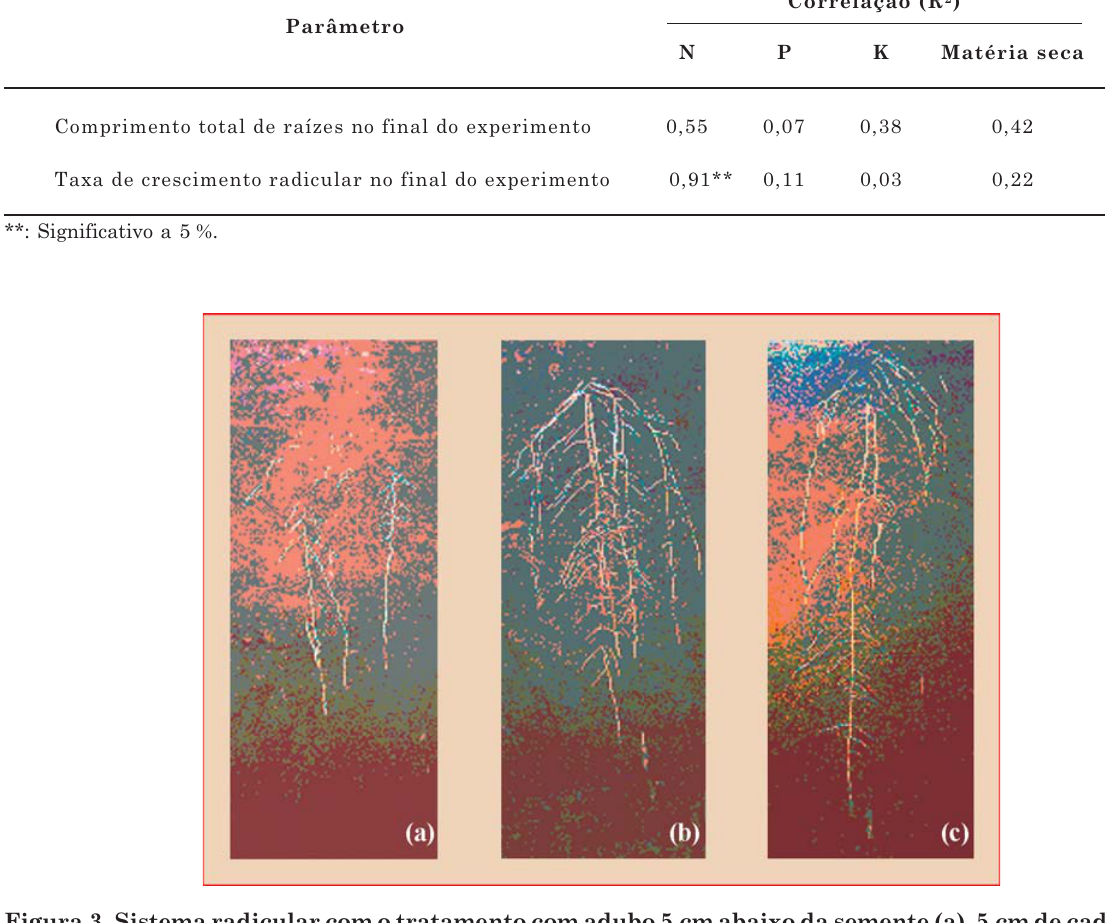
Figura 3. Sistema radicular com o tratamento com adubo 5 cm abaixo da semente (a), 5 cm de cada lado da semente (b) e 5 cm ao lado da semente